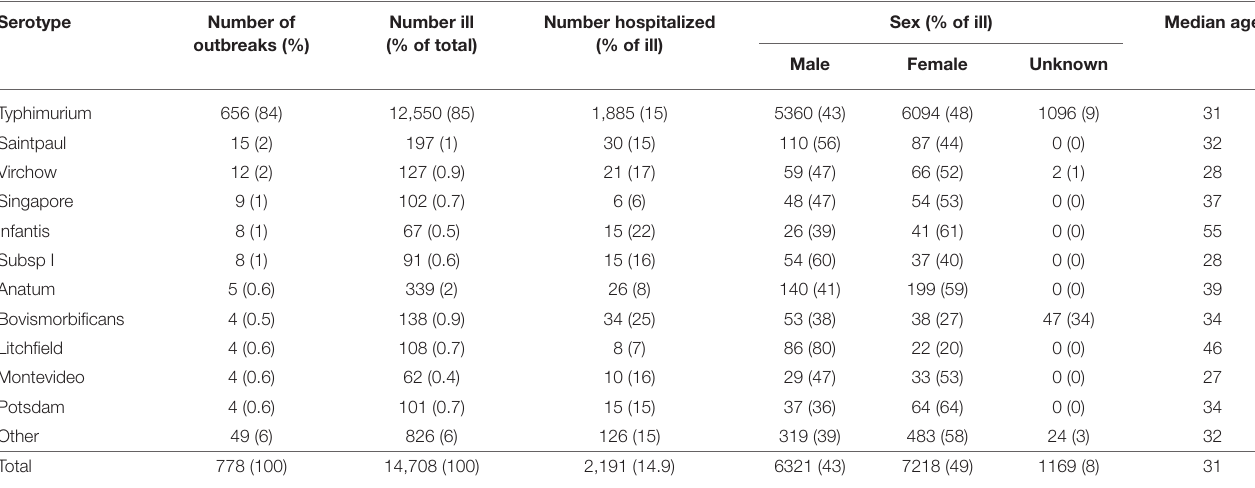
TABLE 3 | Number of reported foodborne or suspected foodborne Salmonella spp. outbreaks, ill persons, hospitalizations, sex, and median of outbreak median age by serotype, Australia, 2001-2016.